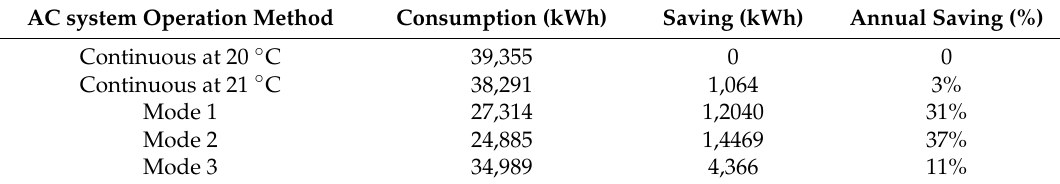
Table 5. Annual energy consumption under the continuous and different modes of AC operation for House 2.